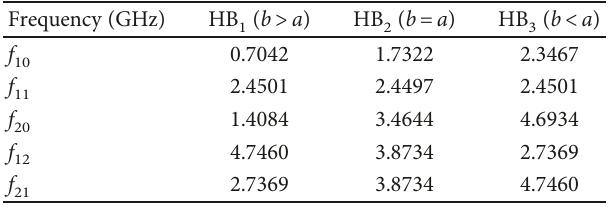
Table 2: Resonant modes closest to TM x Mathematica [29]).